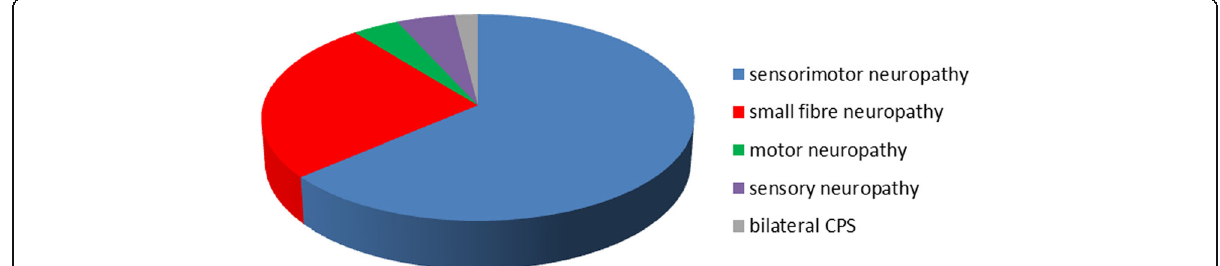
Fig. 1 Neuropathy subtypes (in percent)